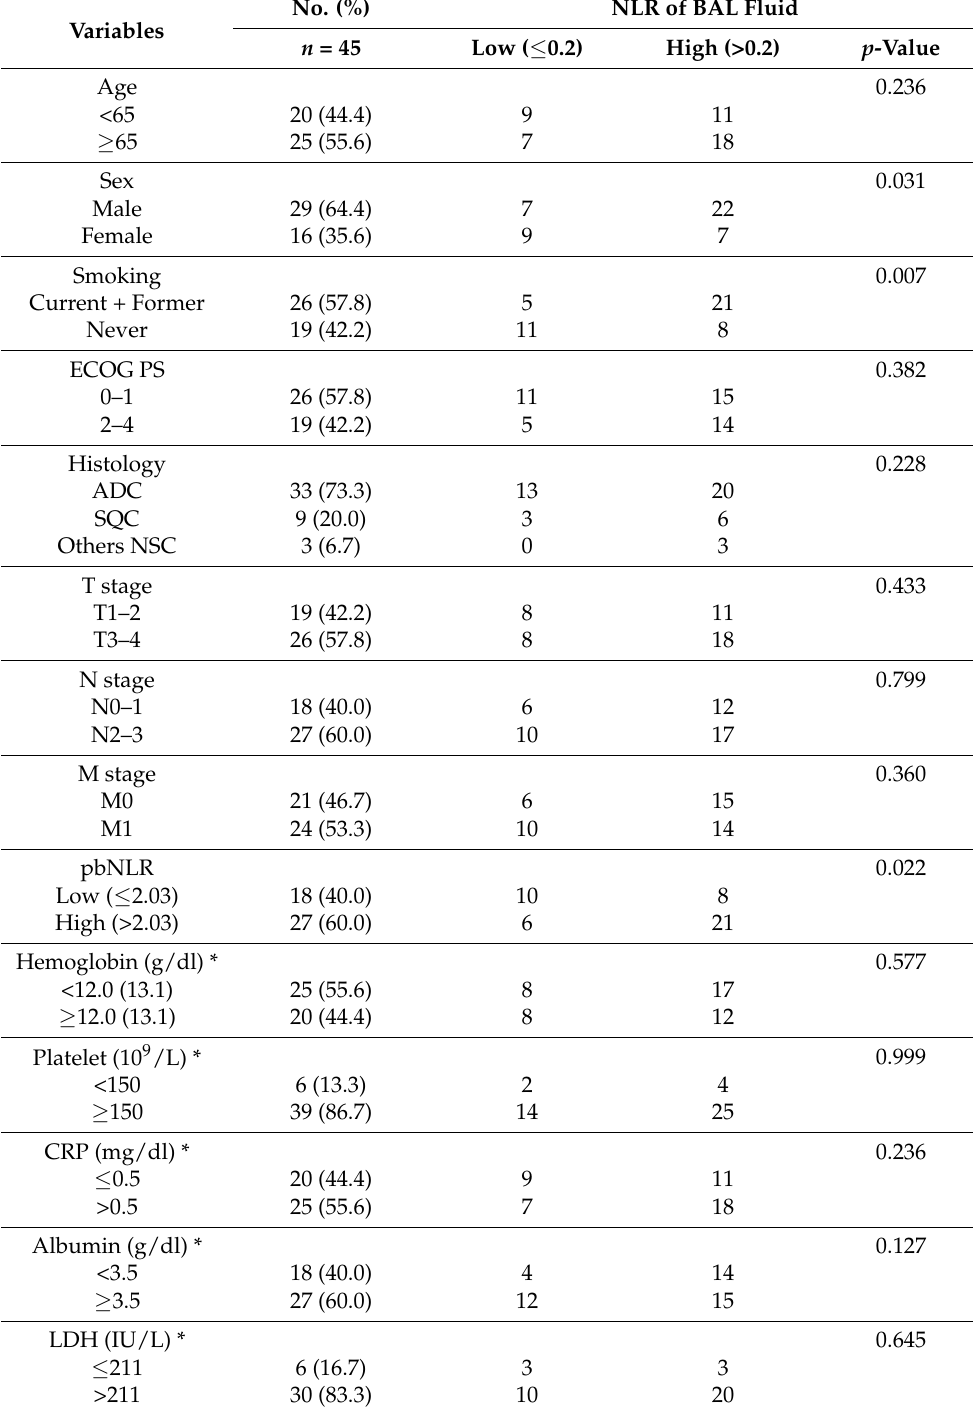
Table 1. Baseline characteristics according to the neutrophil to lymphocyte ratios (NLRs) in bron- choalveolar lavage (BAL)